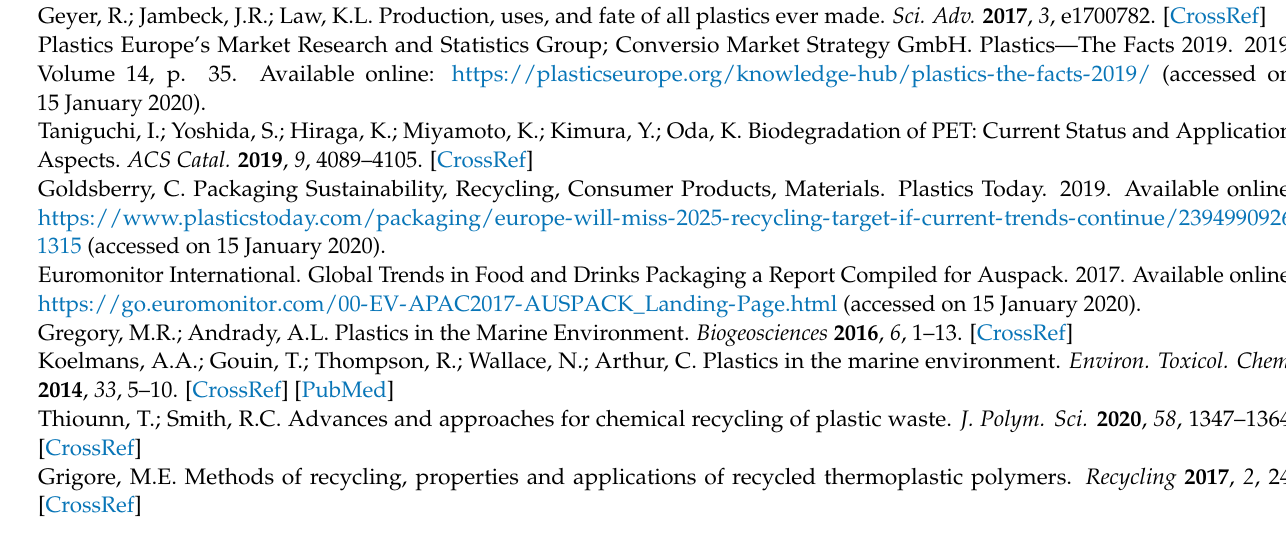
Figure S4C. FTIR spectra of the 2000 cm − 1 to 1000 cm − 1 region of the treatment with the isolates Curvularia trifolii CBMAI 2111 and Trichoderma atroviride CBMAI 2071 in PET1; Figure S4D. FTIR spec- tra of the 1000 cm − 1 to 400 cm − 1 region of the treatment with the isolates Curvularia trifolii CBMAI 2111 and Trichoderma atroviride CBMAI 2071 in PET1; Figure S4E. FTIR spectra of the 4000 cm − 1 to 3000 cm − 1 region of the treatment with the isolates Curvularia trifolii CBMAI 2111 and Trichoderma atroviride CBMAI 2071 in PET2; Figure S4F. FTIR spectra of the 3000 cm − 1 to 2000 cm − 1 region of the treatment with the isolates Curvularia trifolii CBMAI 2111 and Trichoderma atroviride CBMAI 2071 in PET2; Figure S4G. FTIR spectra of the 2000 cm − 1 to 1000 cm − 1 region of the treatment with the isolates Curvularia trifolii CBMAI 2111 and Trichoderma atroviride CBMAI 2071 in PET2; Figure S4H. FTIR spectra of the 1000 cm − 1 to 400 cm − 1 region of the treatment with the isolates Curvularia trifolii CBMAI 2111 and Trichoderma atroviride CBMAI 2071 in PET2; Table S1. Gradient programming applied to the chromatographic separations; Table S2. PET nanoparticle conversion (%) results after fifteen days of analysis; Table S3. Lipase and esterase activities determined by HTS with esterified fluorescent probes (results expressed as mean ± standard deviation, n = 4, analysis time of 96